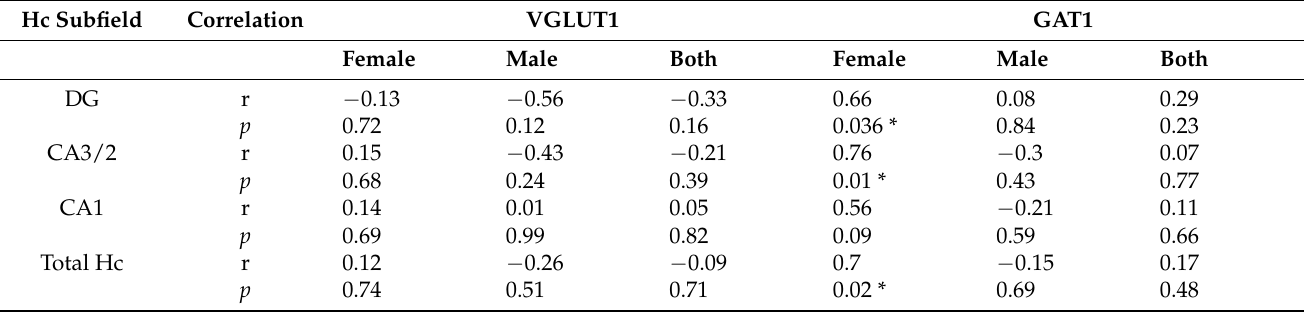
Table A1. Correlation of education years with neuronal markers in donors grouped by